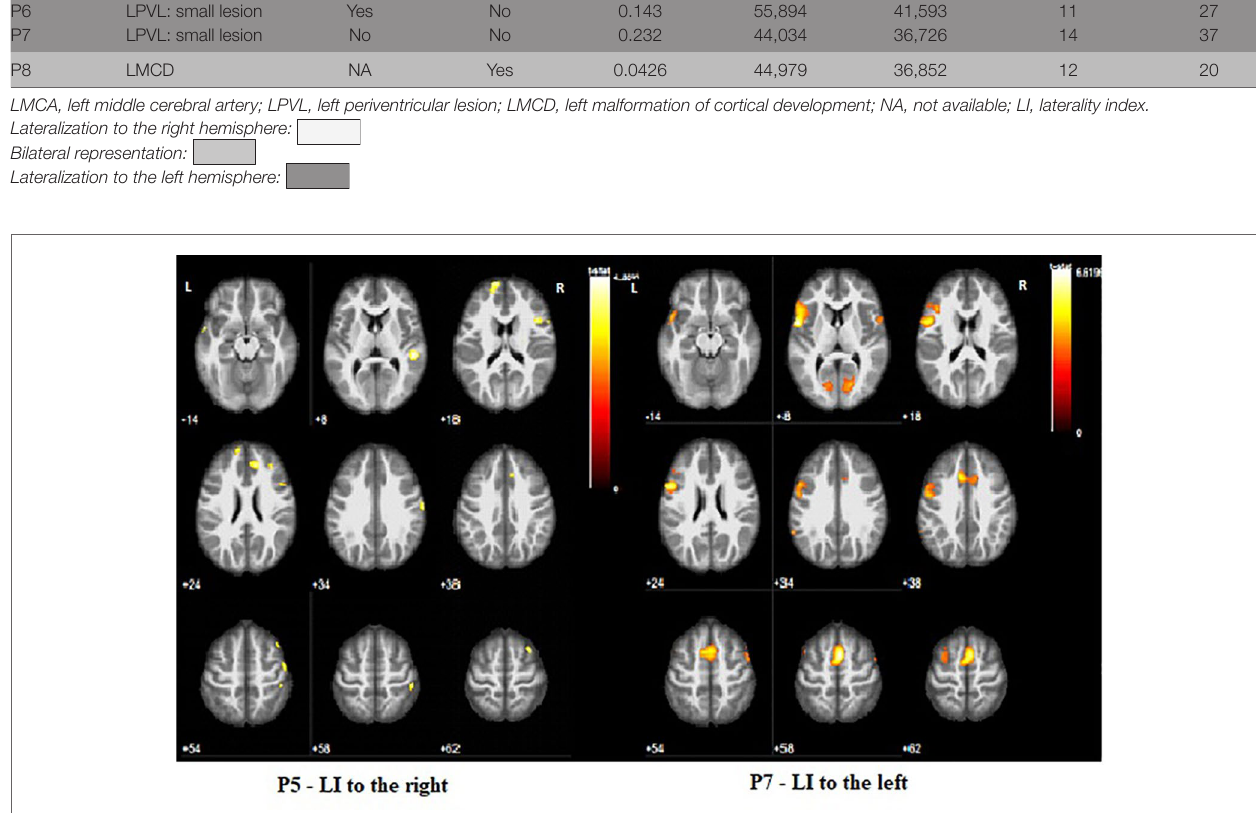
FIgURE 4 | Two types of activation during WG task. None of the patients shown on the figure was found to be